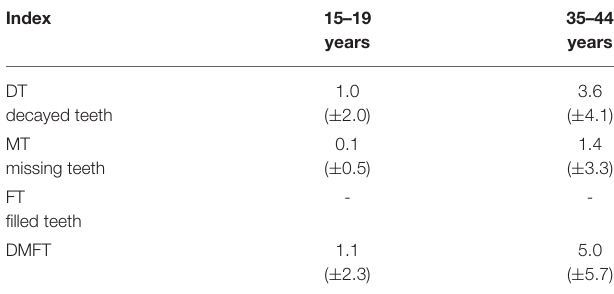
TABLE 1 | Mean (standard deviation) of